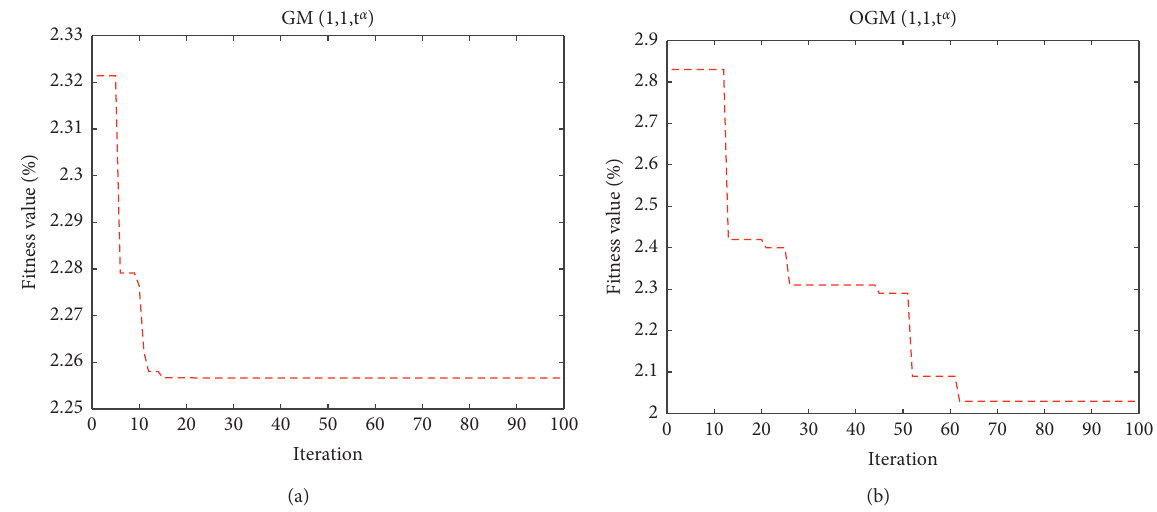
Figure 2: Track of seeking for the optimal parameters of the GM(1,1, t α ) model (a) and the novel model